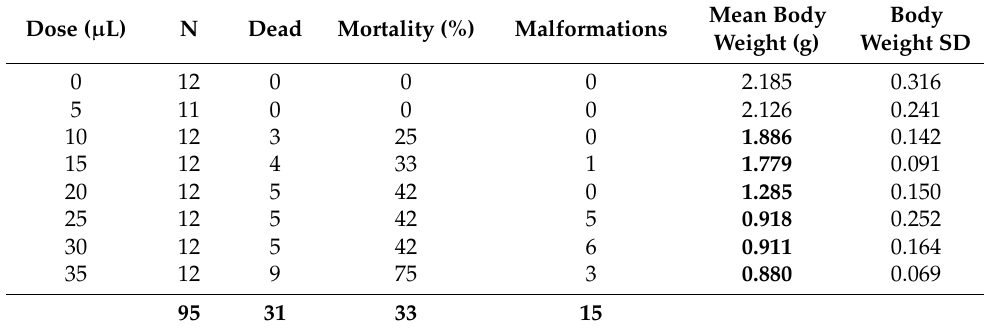
Table 1. ED 9 embryotoxicity due to DMSO injection on ED